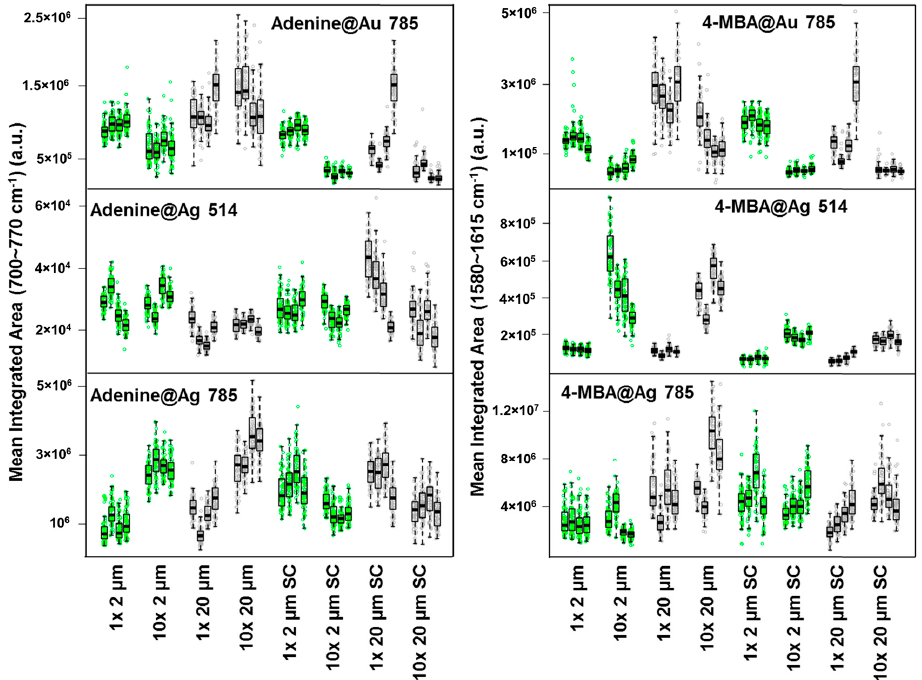
Figure 4. Comparison of the distributions of SERS intensities integrated over the area of the adenine and 4-MBA band. Each box represents the complete distribution of integrated intensities, calculated over a SERS map. Boxes are grouped according to analyte, metal and excitation wavelength, with four replicas (i.e., boxes) for each set of conditions (NPs conc: 1×, 10×; paper average pore size: 2, 20 µm, presence of sodium citrate: SC). For the distributions, the intra- and inter-sample Relative Standard Deviation (RSD%) values are reported in Tables 1–3. Different colors correspond to different average paper porosity (green for 2 µm, grey for 20 µm). Along the median value, the first and the third quartiles of the data distributions are indicated, as bottom and top of the boxes.